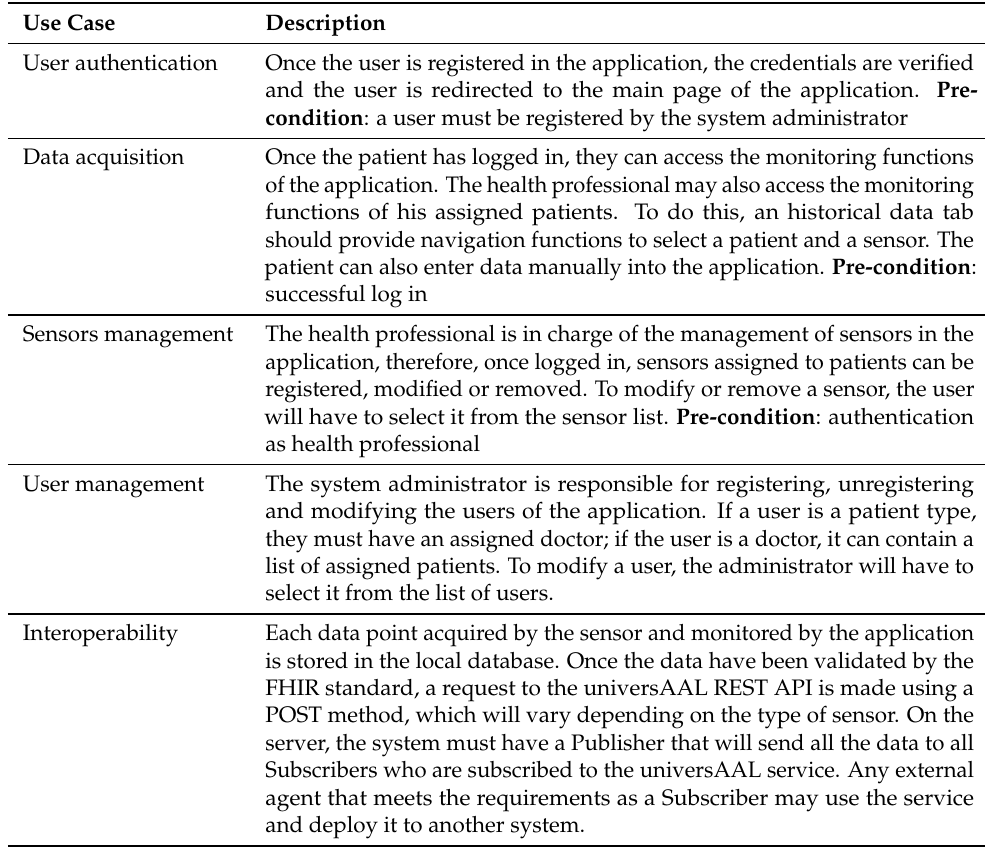
Table 2. Use cases considered for the definition of the